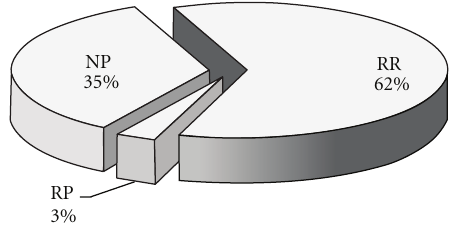
Figure 3: Emergy input ratio of